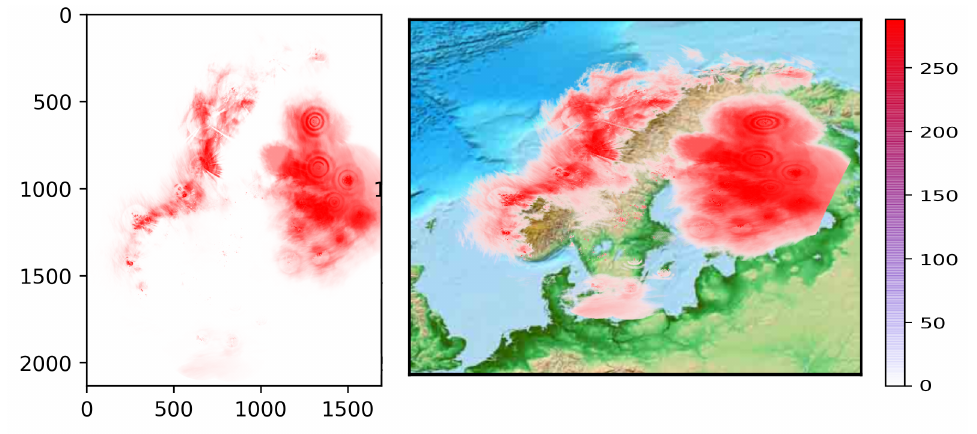
Figure 7. A visualization of the number of missing data points in the MET dataset during a day. Each pixel in the picture represents the number of times the data were present during the day. A pixel is colored in dark red when the data were present for all acquisitions during the day and white/transparent when data were missing for the entire day. On the left, there is a visualization of the data matrix; on the right, there is a visualization of the data projected onto a map.